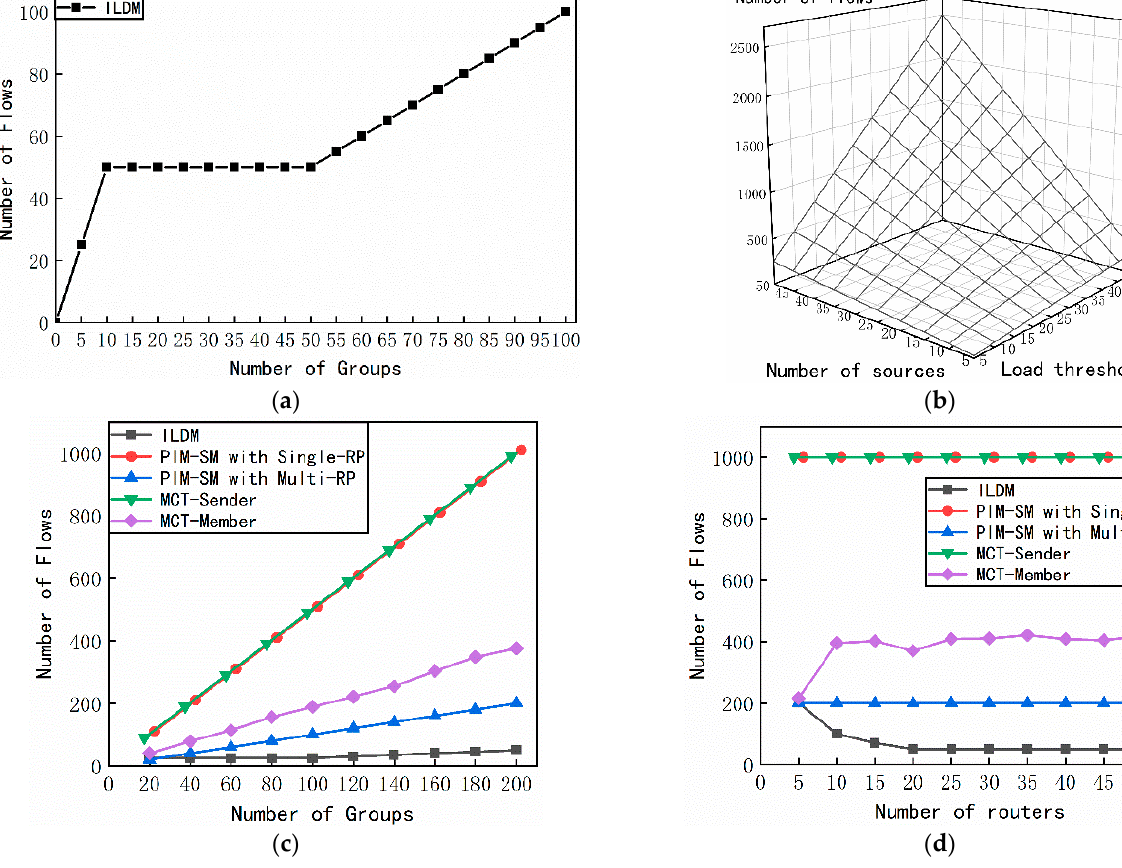
Figure 6. The comparison of maximum core load. ( a ) The variation trends of maximum core load with the different number of groups in ILDM; ( b ) the variation trends of maximum core load with the different number of sources and load threshold in ILDM; ( c ) the comparison of the maximum core load in different methods with the different number of groups; ( d ) the comparison of the maximum core load in different methods with the different number of routers.